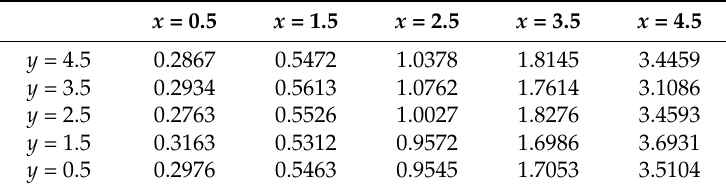
Table 2. Voltage ratios calculated ( R 2) using